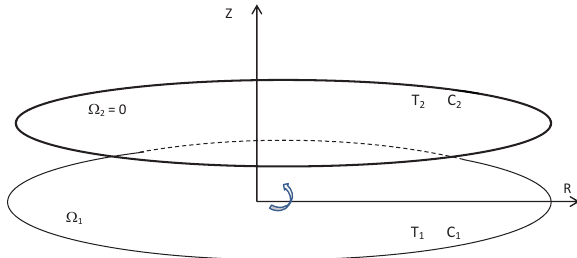
Fig. 1: Geometry of the flow